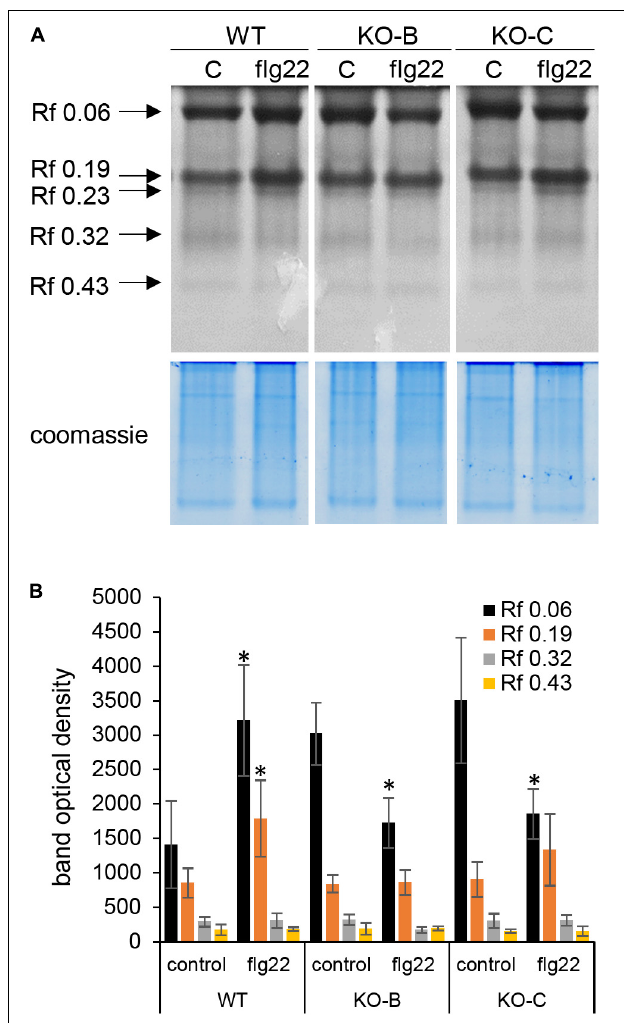
FIGURE 8 | Examination of chitinase activity in the roots of wild type (WT) and HvMPK3 KO lines (KO-B and KO-C) in response to flg22. (A) Chitinase activity on native PAGE gels. Arrows indicate chitinase isozymes with designated relative mobility (Rf). Right panel: visualization of proteins on gel in A by Coomassie staining. (B) Quantification of band intensities in (A) . Asterisks indicate statistically significant difference between flg22-treated and control samples. Uncropped, full original image of the gel is documented in Supplementary Figure 9B